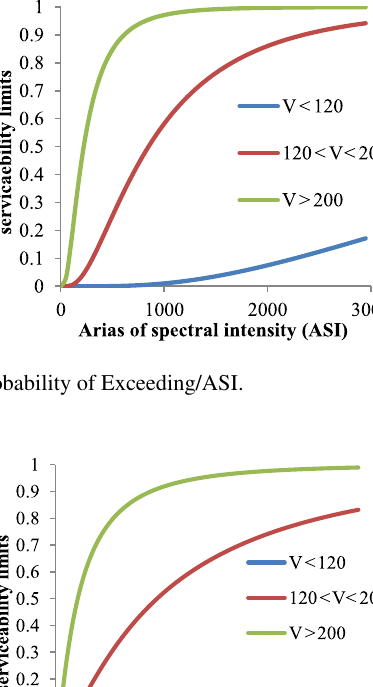
Figure 10. Bridge fragility and upper and lower